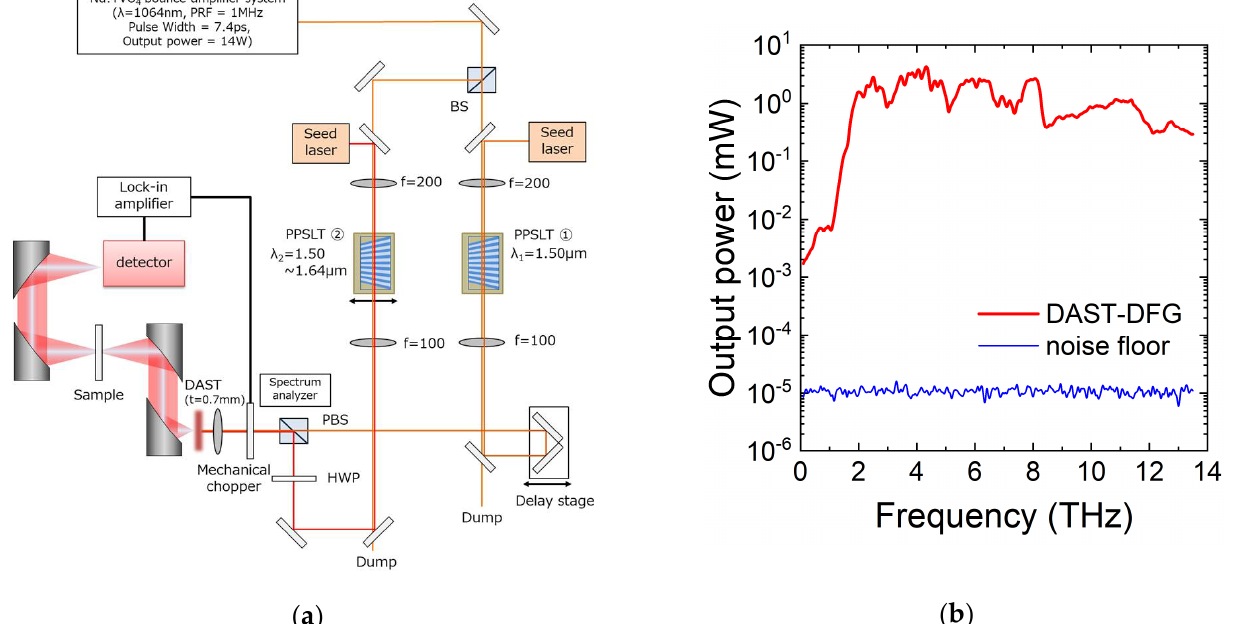
Figure 1. ( a ) Experimental setup of the frequency-domain THz spectroscopy system based on a tunable THz generator formed using a DAST-DFG. ( b ) Plot of the average THz output power spectrum and noise floor level of the THz output generated by the DAST-DFG. More than 50 dB of signal to noise ratio can be observed.